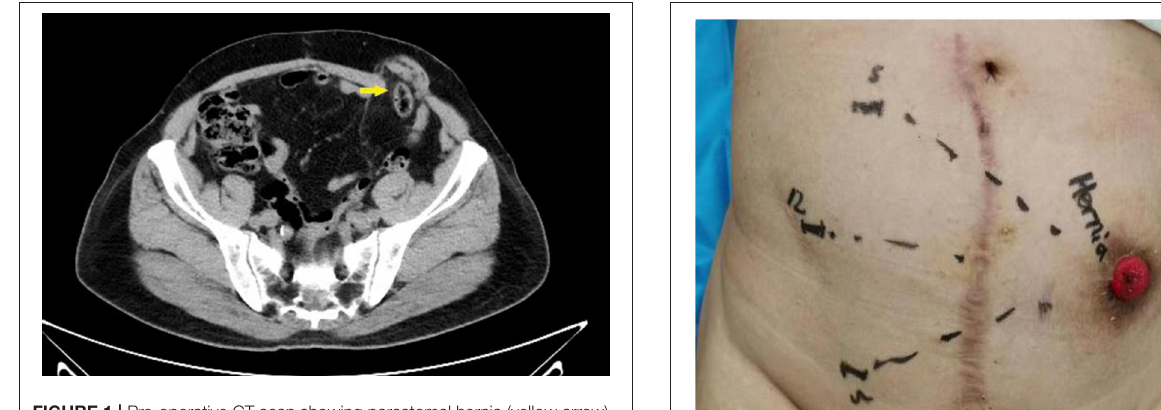
FIGURE 1 | Pre-operative CT scan showing parastomal hernia (yellow arrow).